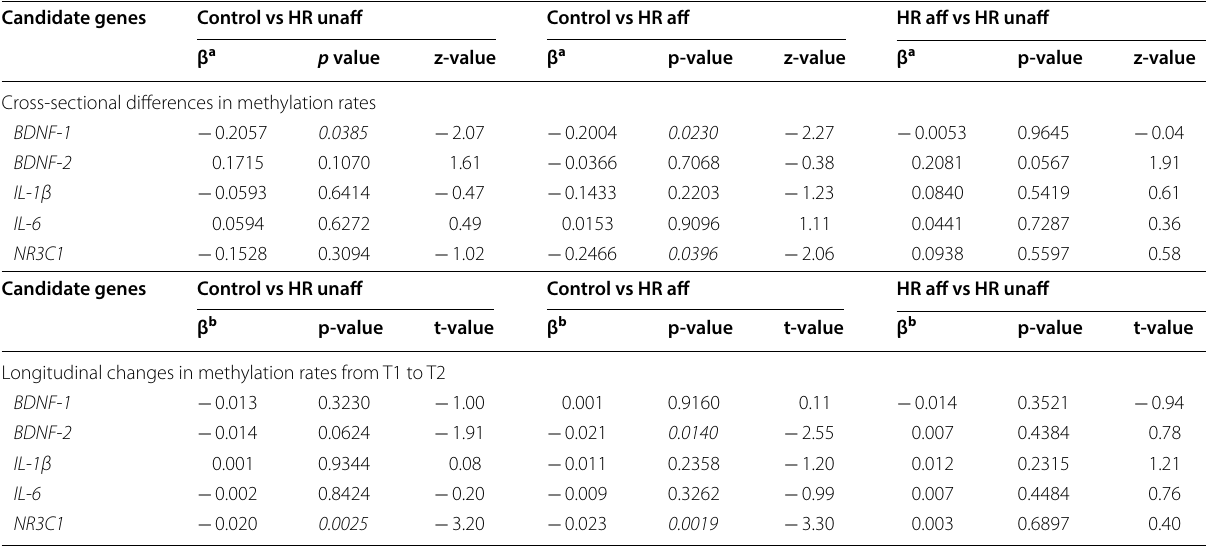
Significant p values are in italic a